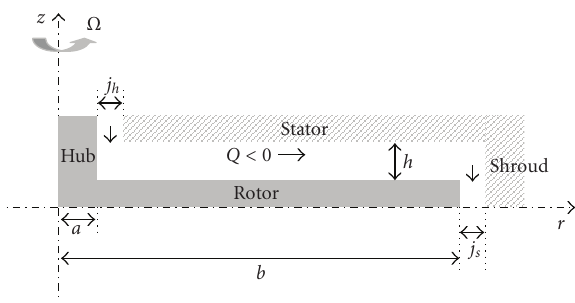
Figure 2: Schematic representation of the rotor-stator configura- tion and